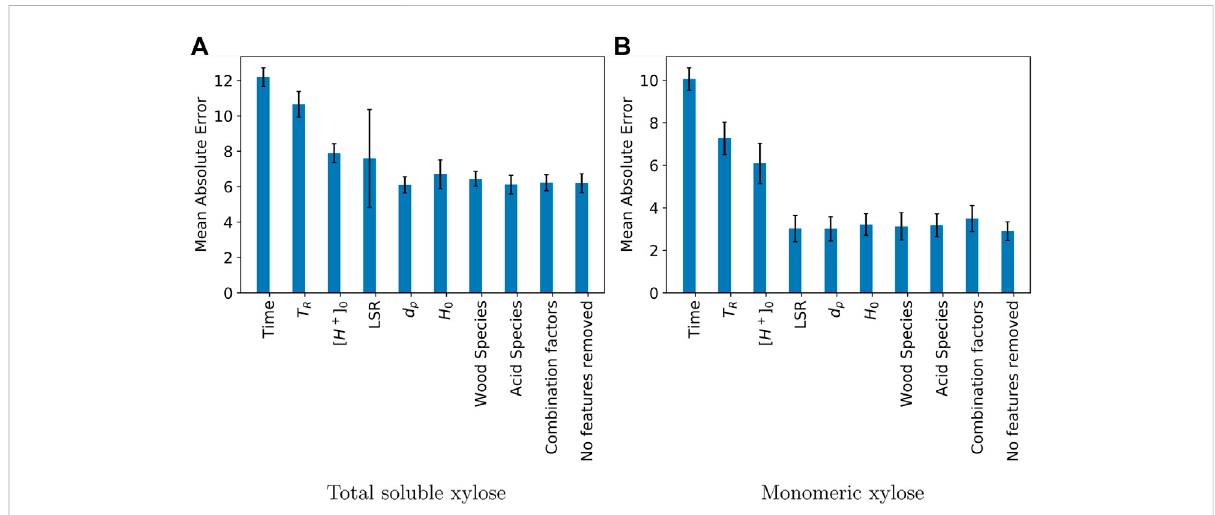
FIGURE 4 Effect of dropping features from the arti fi cial neural network on mean absolute error of test data for: (A) total soluble xylose yield and (B) monomeric xylose yield. Mean absolute error was determined from fi ve replicates of the computational experiment. Its units are percentage points of